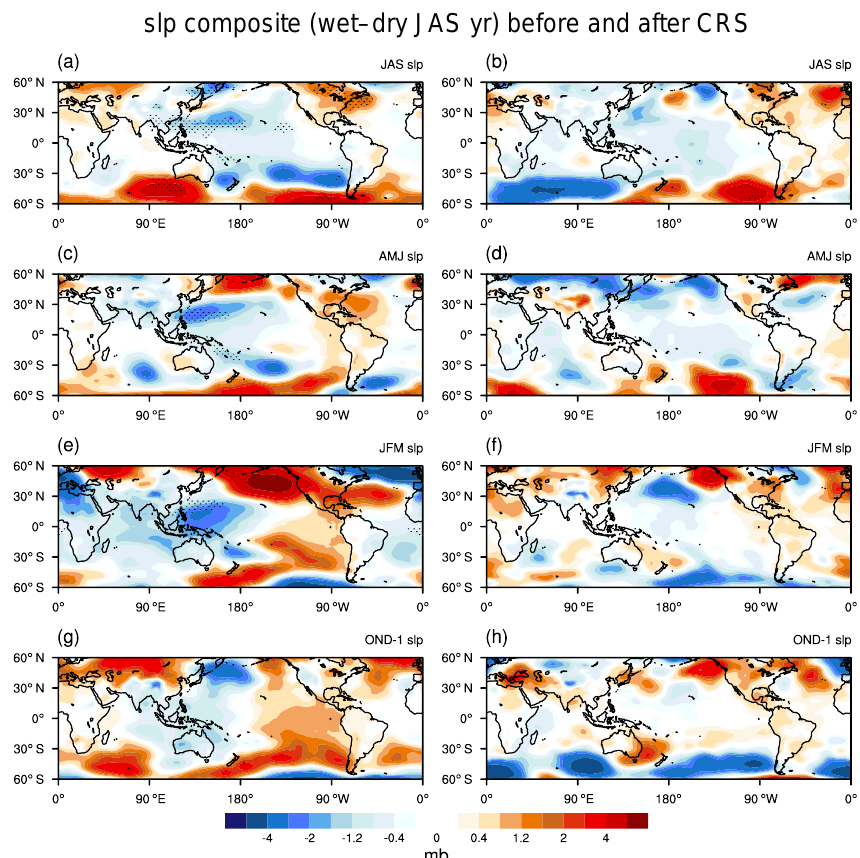
Figure 9. As in Fig. 8 but for sea level pressure (slp) anomaly